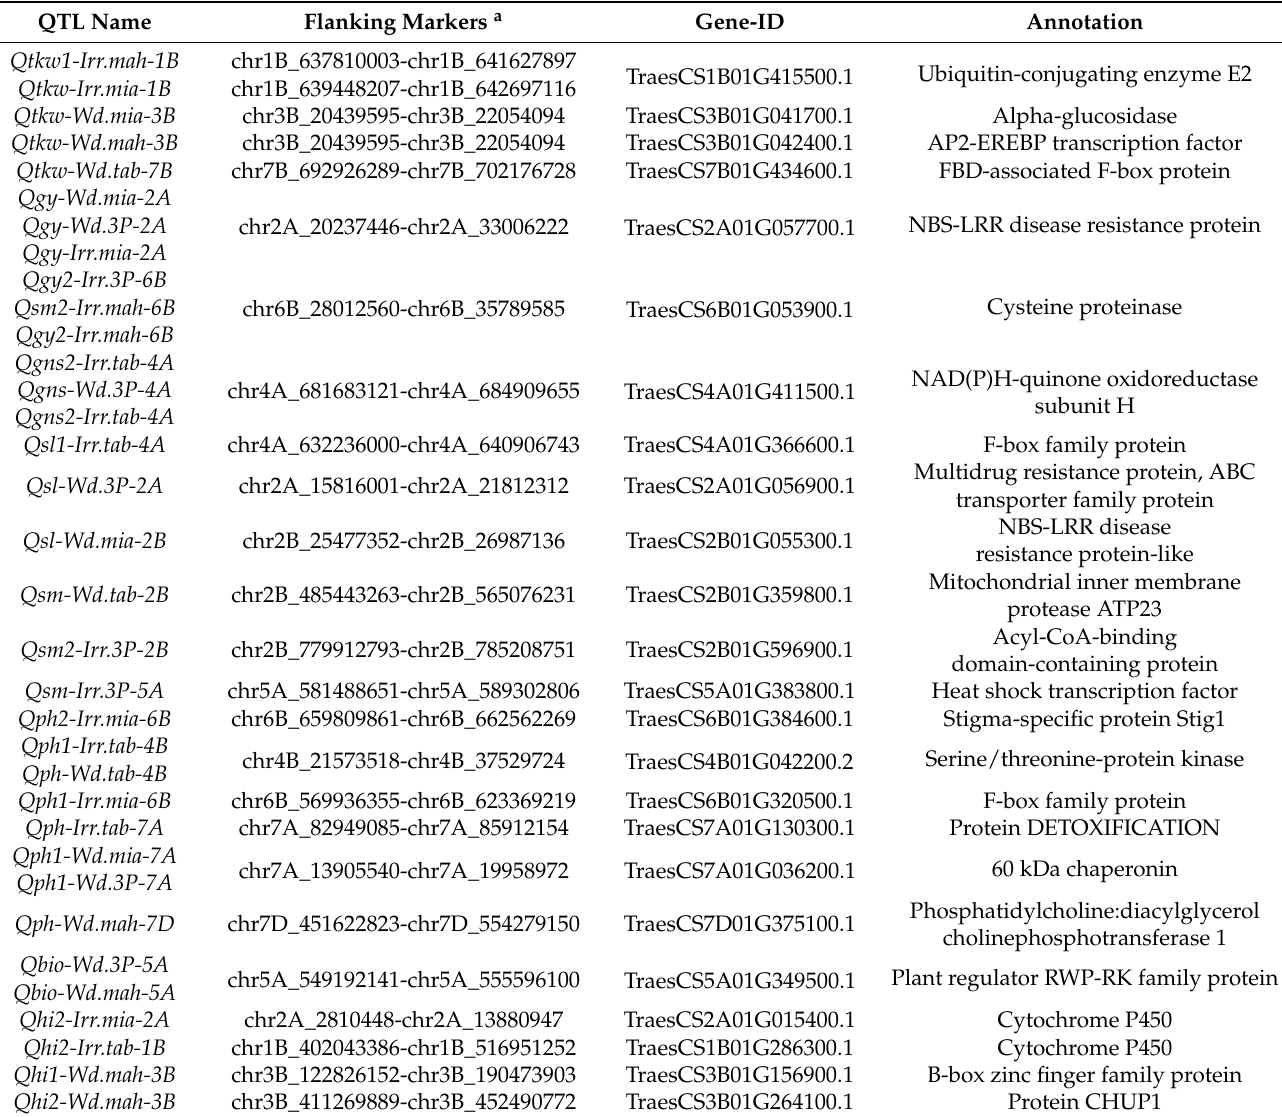
Table 4. List of putatively drought-related genes underlying QTL detected in the RIL population of #49 × Yecora Rojo population under irrigated and water deficit